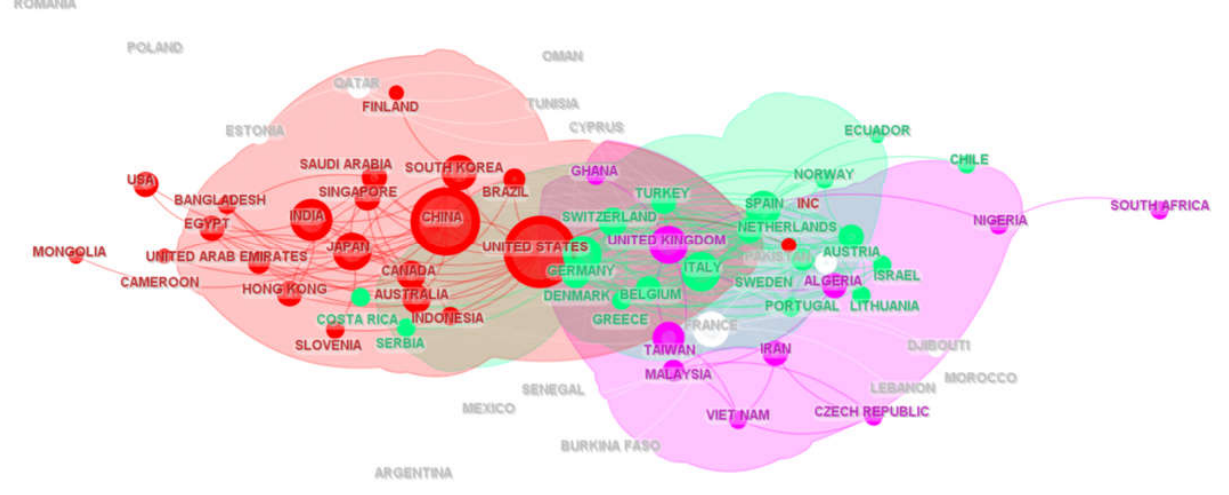
Figure 4. Cooperation between countries.